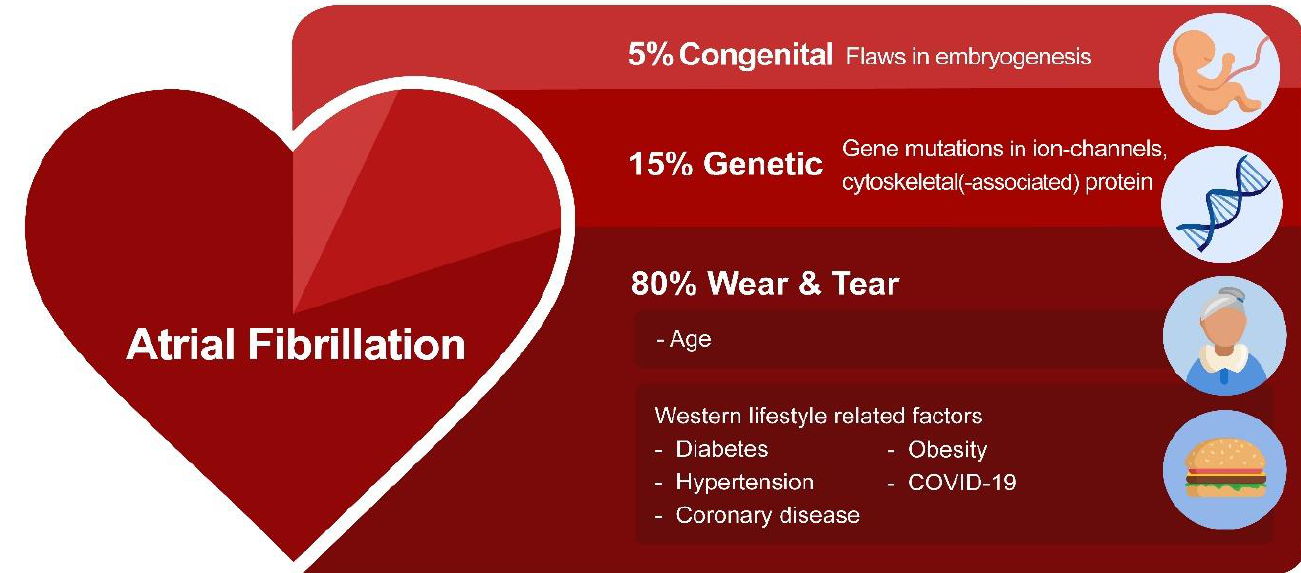
Figure 1. The variety of root causes that drive AF. In most AF patients, environmentally-induced ‘wear and tear’ related to aging or the Western lifestyle triggers AF. In addition, flaws in genetics (variants in ion channels and cytoskeletal proteins) and embryogenesis contribute to AF suscepti-